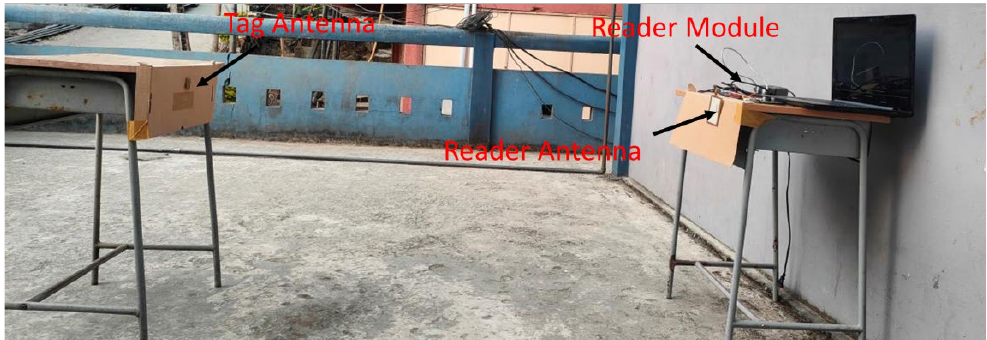
Figure 11. Measurement setup for read range in the free space for maximum distance .